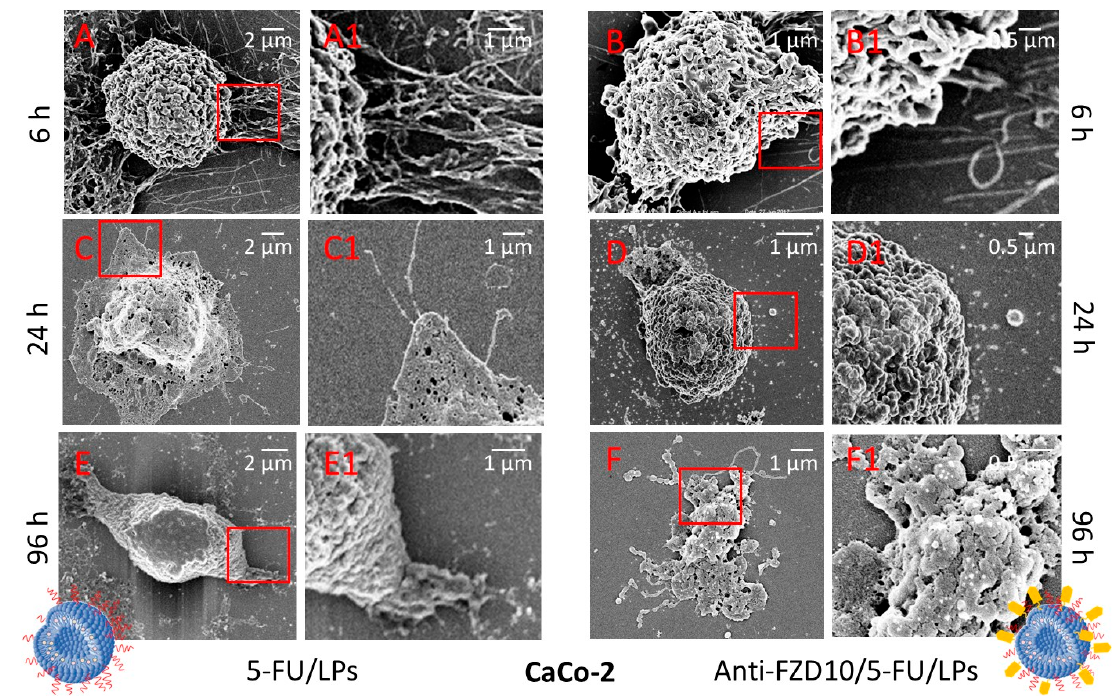
Figure 5. Representative FE-SEM micrographs (EHT = 3.00 kV) and their corresponding close-up details at higher magnification of CaCo-2 cells after treatment with 5-FU/LPs ( A , A1 , C , C1 , E , E1 ) and anti-FZD10/5-FU/LPs ( B , B1 , D , D1 , F , F1 ) for 6, 24 and 96 h. 5-FU concentration: 2 µM.